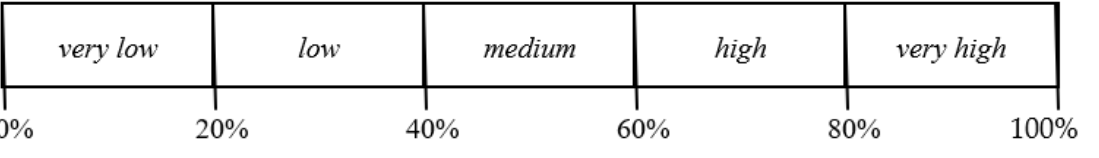
Table 1. The SOFA score. PaO 2 —partial pressure of oxygen in the blood. FiO 2 —fraction of inspired oxygen. MAP—mean arterial pressure.